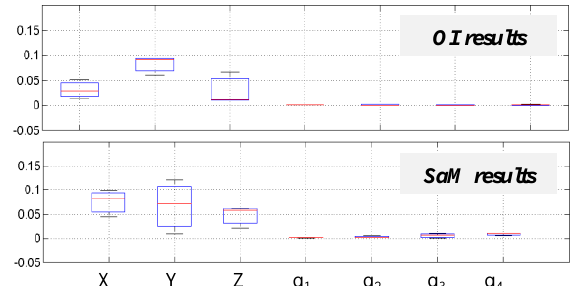
Figure 6. Comparison of the SaM and OI method’s results. Residuals of camera orientations, using Australis results as a reference, for three images with different viewing directions. X, Y, Z are the camera position and q i is the quaternion rotation value.